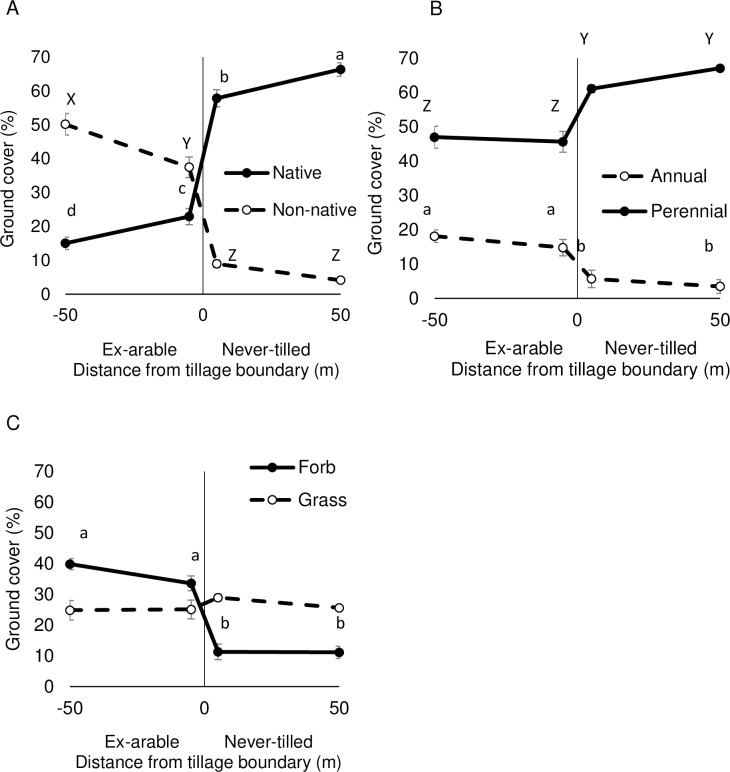
Percent ground cover of (A) native and non-native plants, (B) annual and perennial plants, and (C) forbs and grasses across tillage boundaries. Negative x-axis values are in ex-arable fields. Positive x-axis values are in never-tilled fields. Values represent the mean and standard error associated with the 25 sampled fields (values from replicate plots and years were averaged prior to calculations). Different letters are different at the α = 0.05 level.